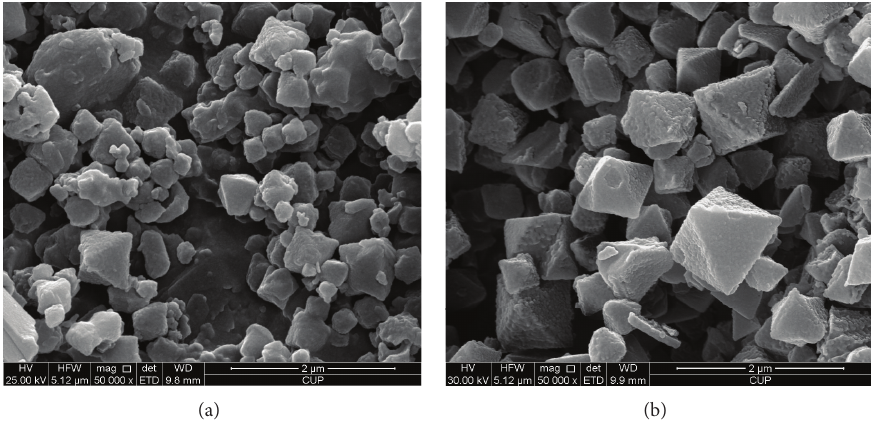
Figure 4: SEM images of MIL-53 (Fe) samples. (a) 1 day, (b) 3